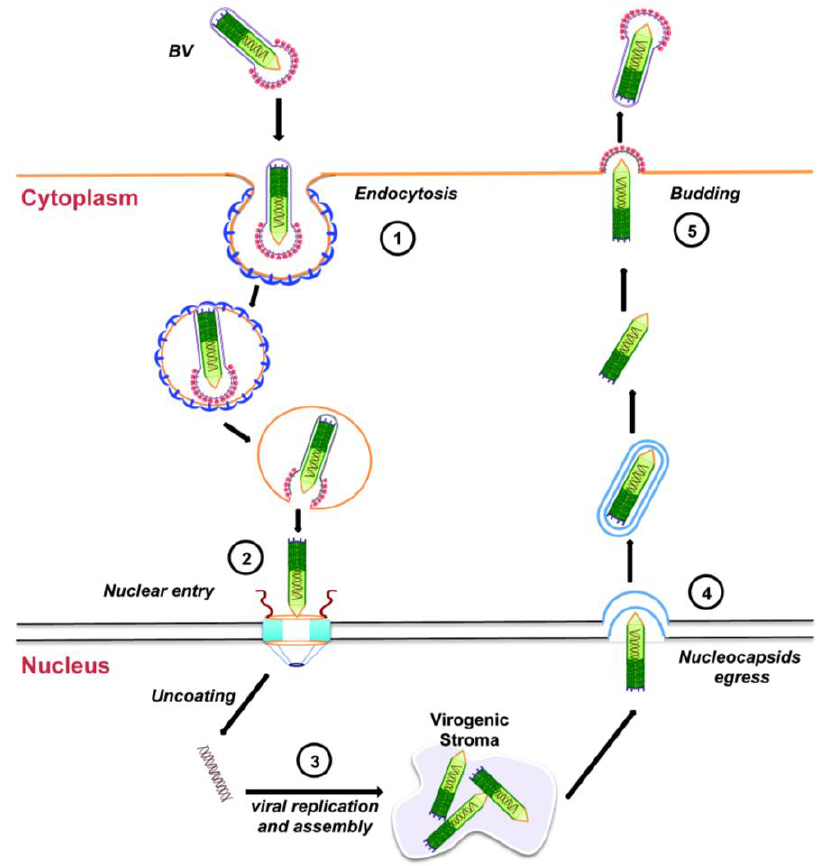
Figure 3. Budded virus infection cycle in cultured cells. See text for